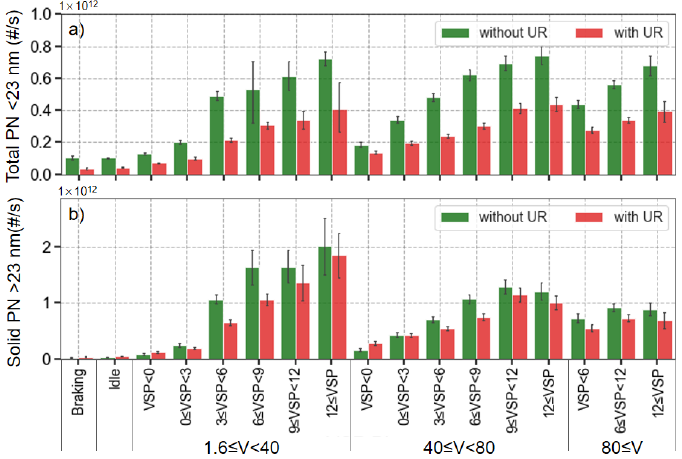
Figure 4. Comparison of average total <23 nm ( a ) and solid >23 nm ( b ) PN emission rates of different VSP-bins with and without the illegal application of urea regulator.